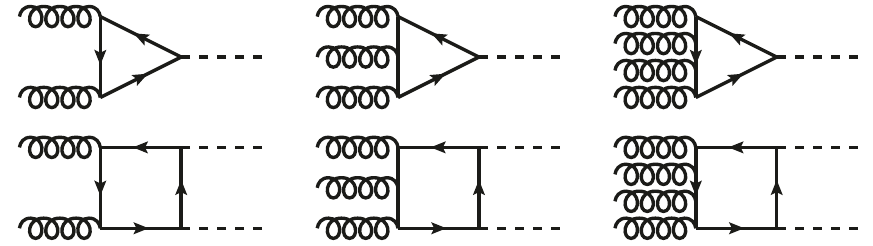
Figure 5 . Sample Feynman diagrams contributing to the building